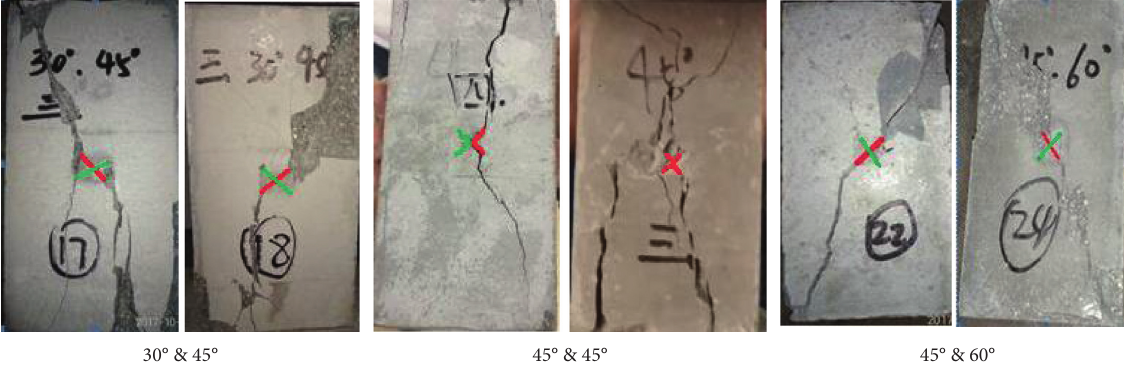
Figure 4: Failure mode of single “X” fracture specimen with different